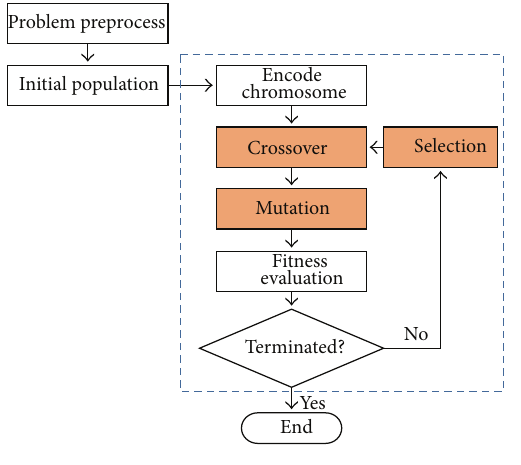
Figure 1: Flowchart of